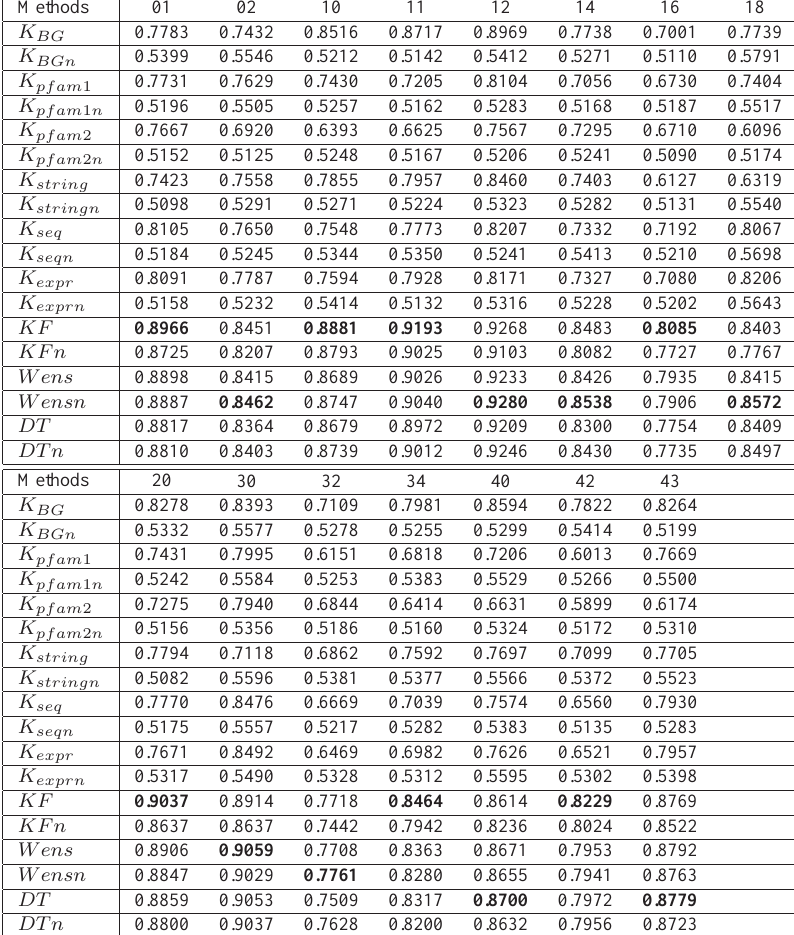
Table 4: Performances of SVMs trained on single sources of data compared with performances of data integration methods (AUC averaged across the 5 folds) with 6 no-noisy and 6 noisy data. First column: Identifiers starting with K correspond to SVMs trained on single sources of data. The subscripts correspond to those of the data sets of Table 1. KF stands for Kernel Fusion, Wens for weighted linear ensembles and DT for Decision Templates. The ending ”n” refers to the SVM or data integration method trained with the corresponding noisy data. The other columns show the AUC results for the 15 FunCat classes. FunCat classes are represented through their two-digits identifiers (see Table